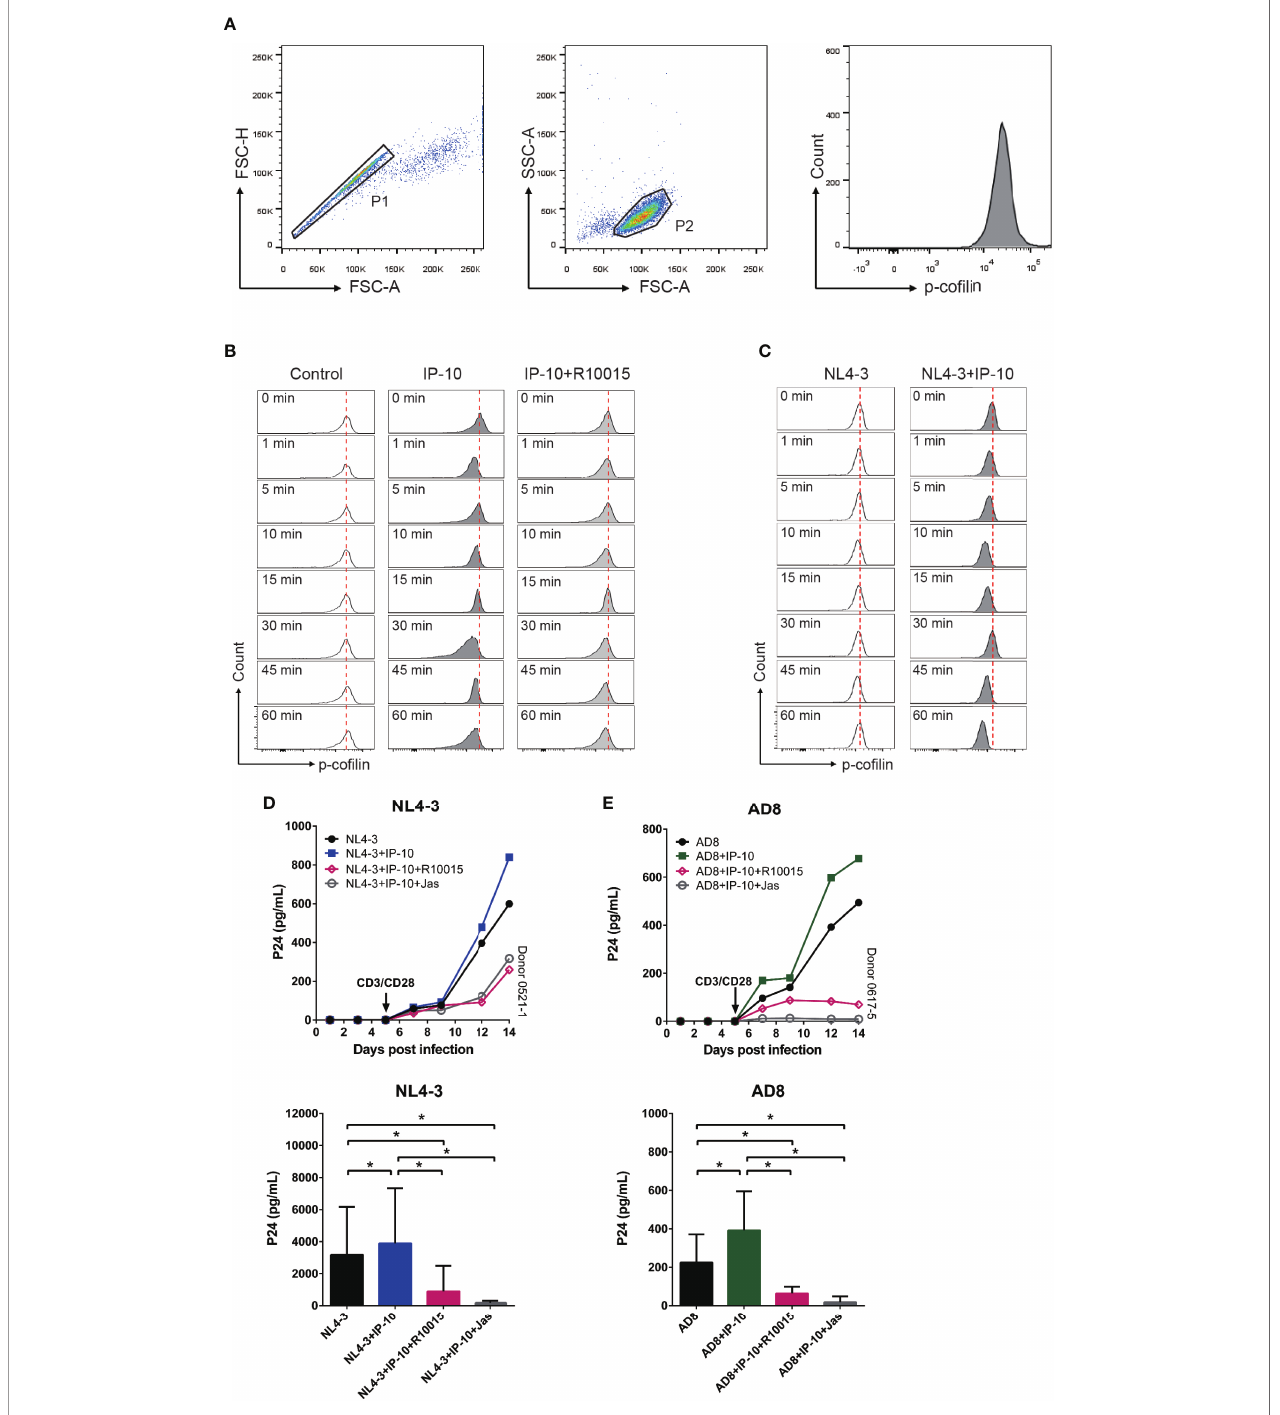
FIGURE 6 | IP-10 activates LIMK – co fi lin signaling in resting memory CD4 + T cells. (A) Gating strategy for the experiment evaluating the effect of IP-10 on co fi lin activation. (B, C) Representative fl ow cytometry plots from the experiment evaluating the effect of IP-10 on co fi lin phosphorylation over time. Resting memory CD4 + T cells were treated with IP-10 (5 ng/ml) and IP-10 (5 ng/ml)+R10015 (100 m M) (B) or NL4-3 and NL4-3+IP-10 (5 ng/ml) (C) for the indicated times, and p-co fi lin was marked with Ser3, followed by fl ow cytometry analysis. The red dashed lines represent localized baselines for co fi lin phosphorylation. Co fi lin dynamics were evaluated at 1, 5, 10, 15, 30, 45, and 60 min, with the measurement at 0 min serving as the reference value. (D, E) LIMK inhibition abrogates the enhancement of HIV AD8/NL4-3 infection by IP-10. Representative plots of 2 participants are shown. P24 levels of day 14 were compared between groups by one-way analysis of variance (NL4-3: n = 7, AD8: n = 8). * P <